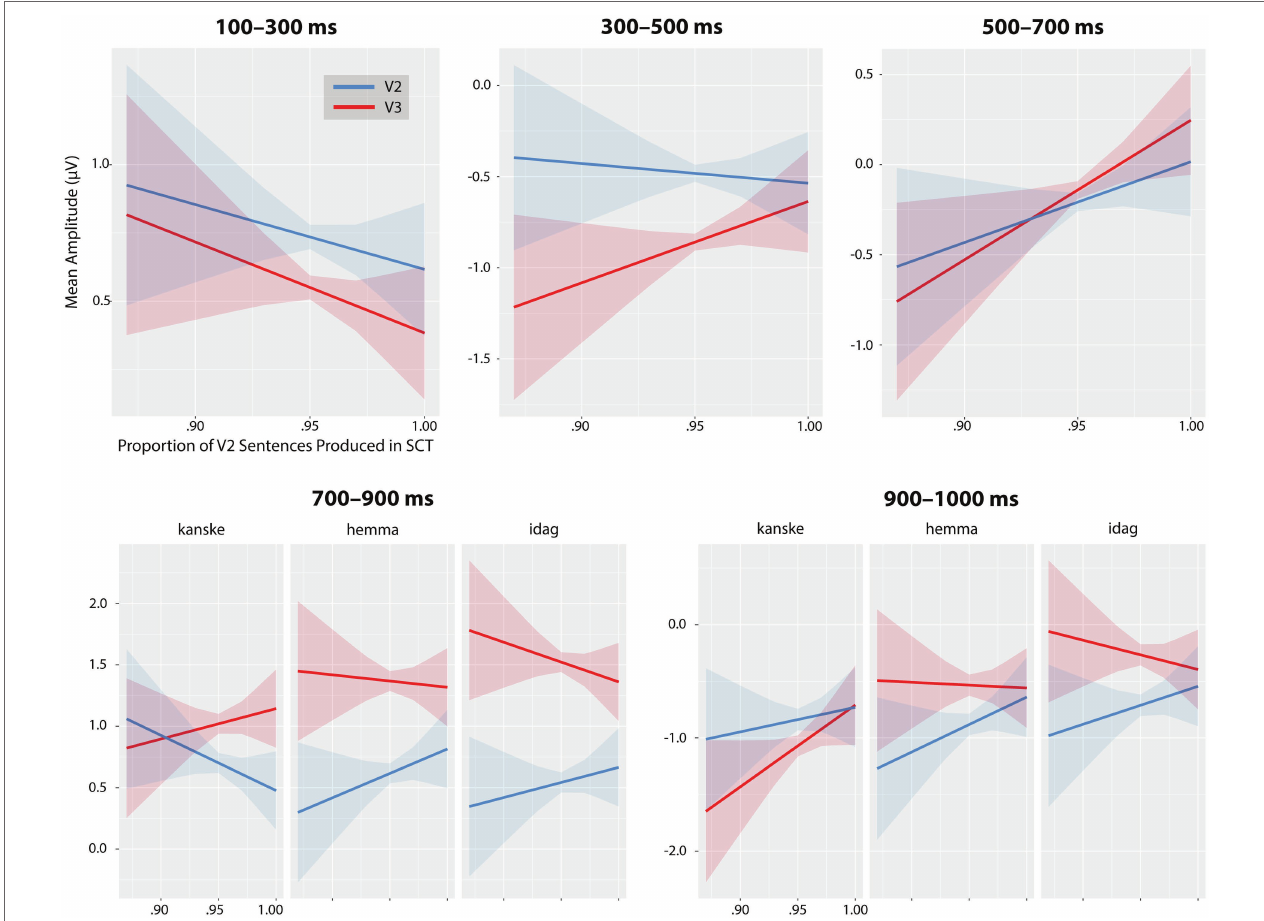
FIGURE 8 | Significant interactions between proportion of produced V2 sentences in SCT and mean amplitudes for V2 (in blue) and V3 (in red) for each time window. Confidence intervals (95%) are shaded. In the first three time windows (100–300, 300–500 and 500–700 ms) the interactions are collapsed across adverbials (since adverb did not interact with sentence position or SCT) while in the two later time windows (700–900 and 900–1,000 ms) the interaction with Adverbial was significant, and so, effects are separated by